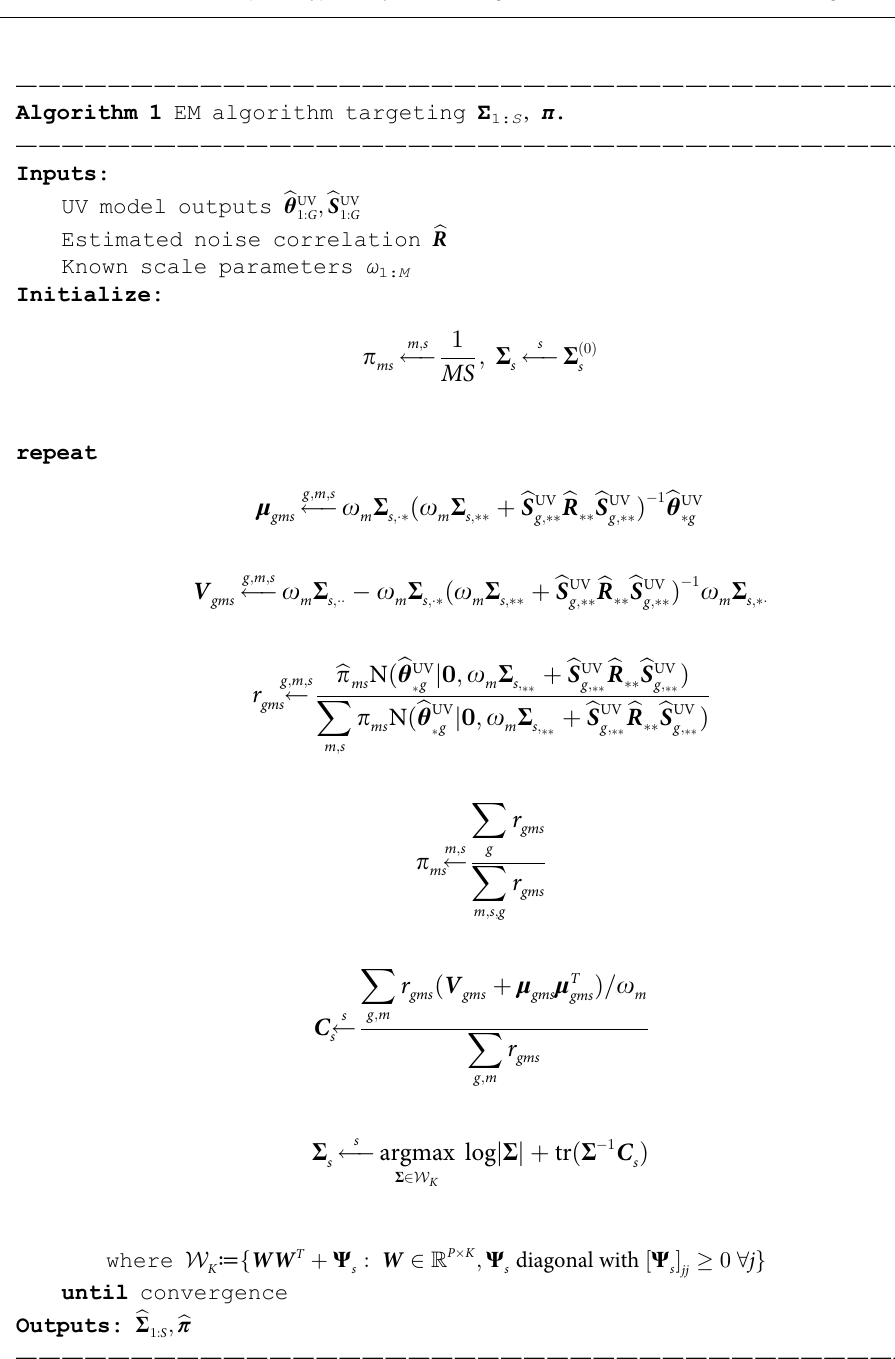
Algorithm 1 EM algorithm targeting Σ 1: S , π